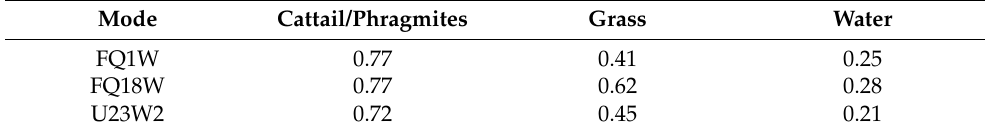
Table 9. Average coherence from April to November, 2018 for wetlands in Long Point. Mode Cattail/Phragmites Grass Water